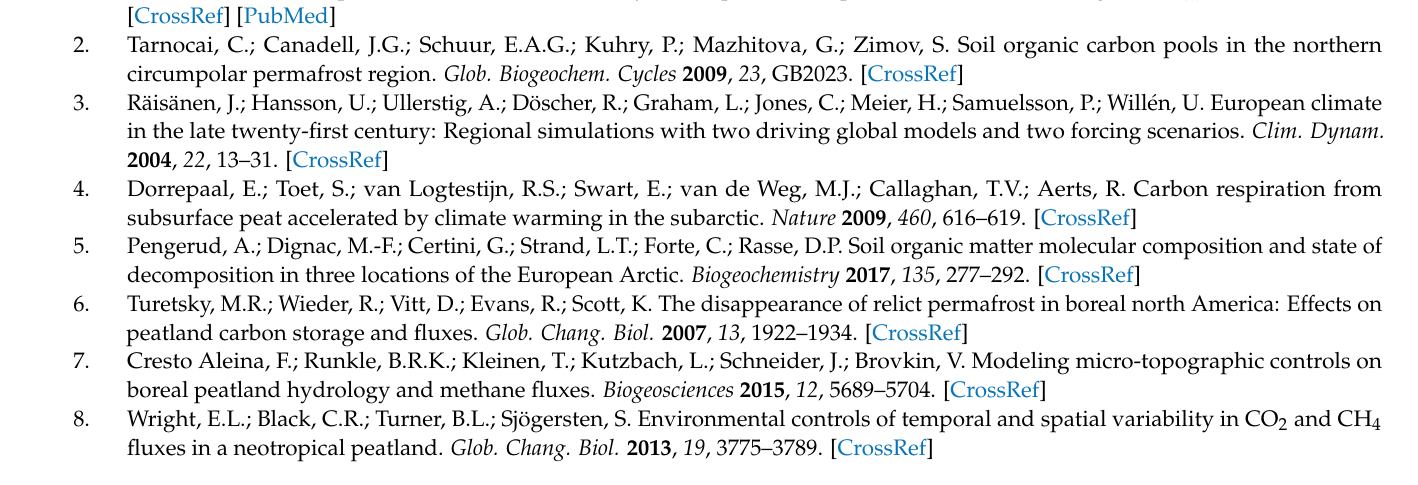
plots; Table S3: Mean and standard deviation of microbial respiration activities among all plots; Table S4: Correlation coefficients after Spearman for basal respiration rates (BR) with soil properties (TC: total carbon concentration, TN: total nitrogen concentration, TP: total phosphors concentra- tion, C/N: carbon to nitrogen ratio, C/P: carbon to phosphors ration, Ash: ash content, pH: pH value, BD: bulk density, Na: sodium concentration, Mg: magnesium concentration, K: potassium concentration, Ca: calcium concentration, and C mic : microbial biomass carbon); Table S5: Correlation coefficients after Spearman for basal respiration rates (BR) separated into the different plots with soil properties (TC: total carbon concentration, TN: total nitrogen concentration, TP: total phosphors con- centration, C/N: carbon to nitrogen ratio, C/P: carbon to phosphors ration, Ash: ash content, pH: pH value, BD: bulk density, Na: sodium concentration, Mg: magnesium concentration, K: potassium concentration, Ca: calcium concentration, and C mic : microbial biomass